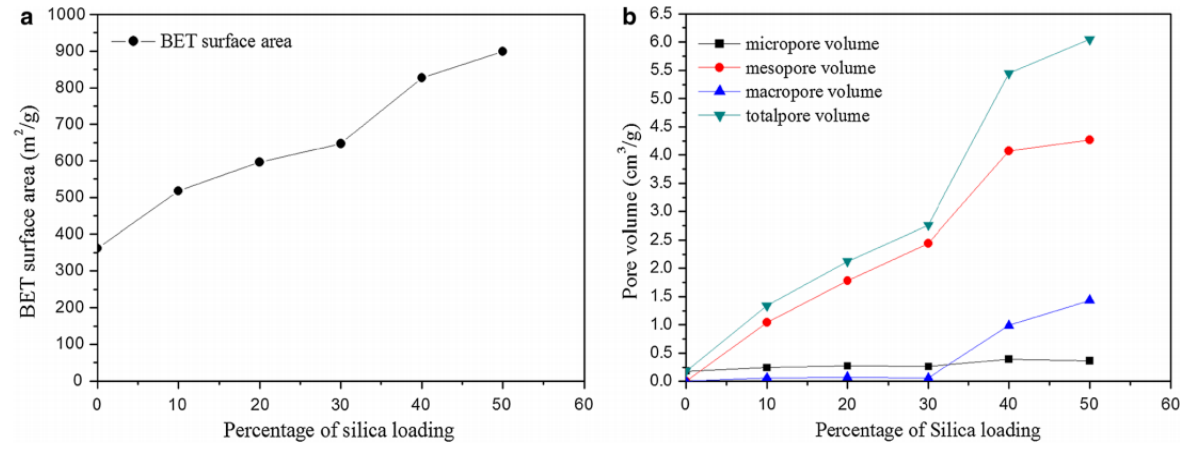
Figure 22. Effects of silica loading on BET surface area ( a ) and pore volume ( b ) of PBZ carbon xerogels (reproduced from the work in [74] with permission).